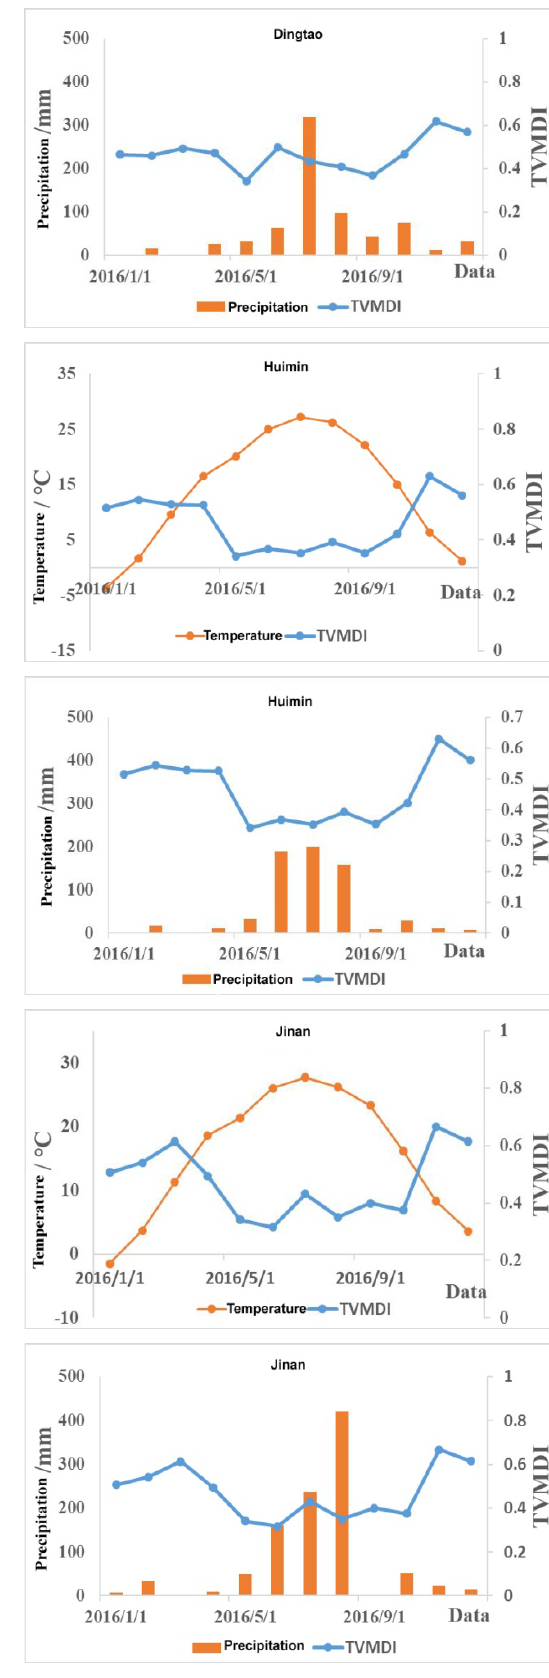
Fig.6 relationship between TVMDI and precipitation